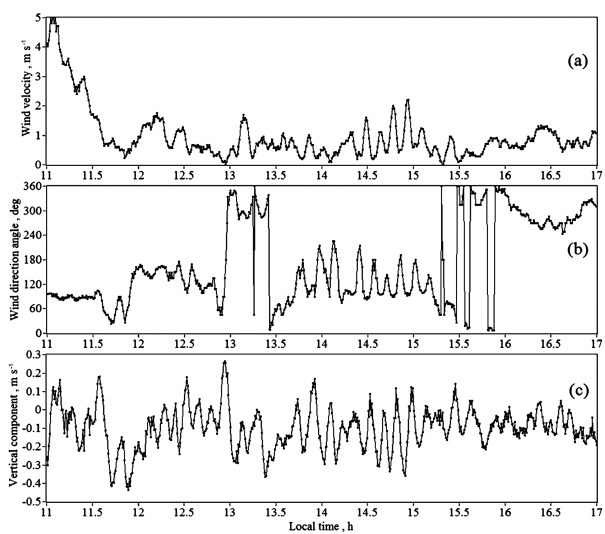
Figure 7. Temporal profiles of the wind speed (a) , the wind di- rection angle (b) and the vertical component of the wind veloc- ity (c) taken from the data of Fig. 5 (measurement height of 636.5m).